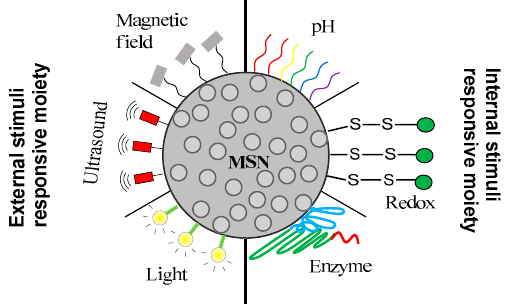
Figure 2. Most relevant stimuli responsive gatekeepers to decorate MSN for controlled cargo release in the cancer site. the cancer